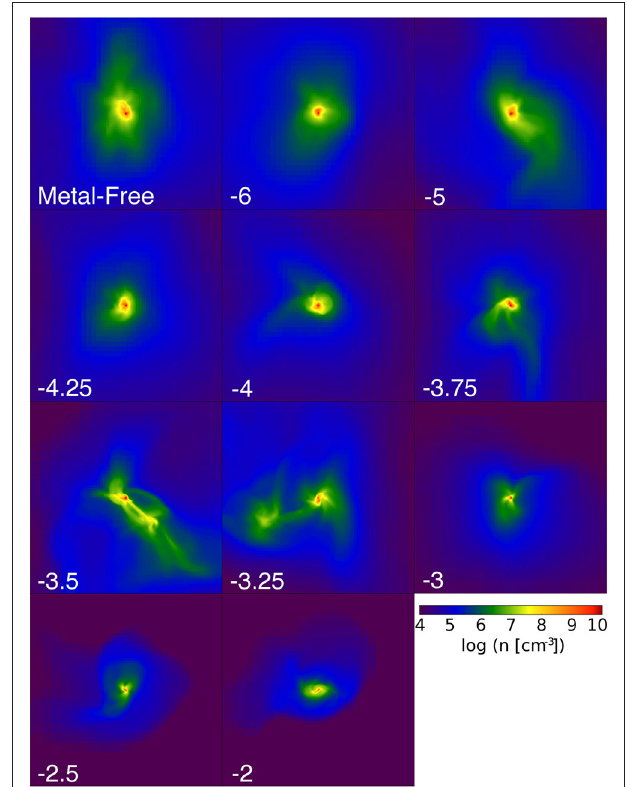
FIGURE 3 | Density projections of the central 0.5 pc in collapsing gas clouds at different metallicities from simulations using Enzo. At metallicities above 10 − 3.5 Z ⊙ , the cloud is able to fragment due to enhanced cooling from metals. Below 10 − 3.5 Z ⊙ , the gas reaches the CMB temperature floor at an early stage and becomes stabilized to fragmentation. Reproduced by permission of the American Astronomical Society, Figure 1 from Smith et al.